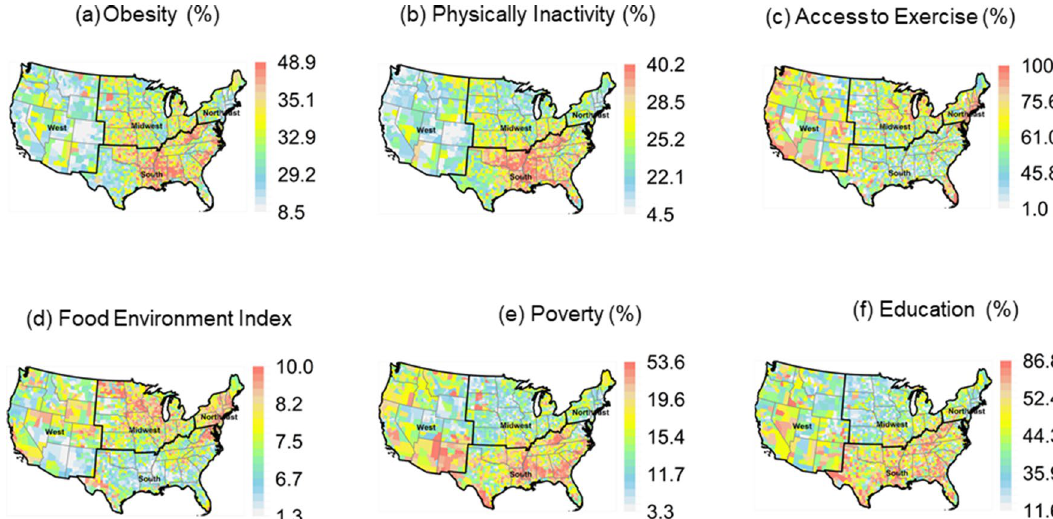
Figure 2. County-level 5-year averages (2013–2017) of six risk factors. ( a ) obesity; ( b ) physical inactivity; ( c ) access to exercise; ( d ) food environment index; ( e ) poverty; and ( f ) education. Maps were created in the R (version 4.0.0) Statistical Computing Environment 39 .